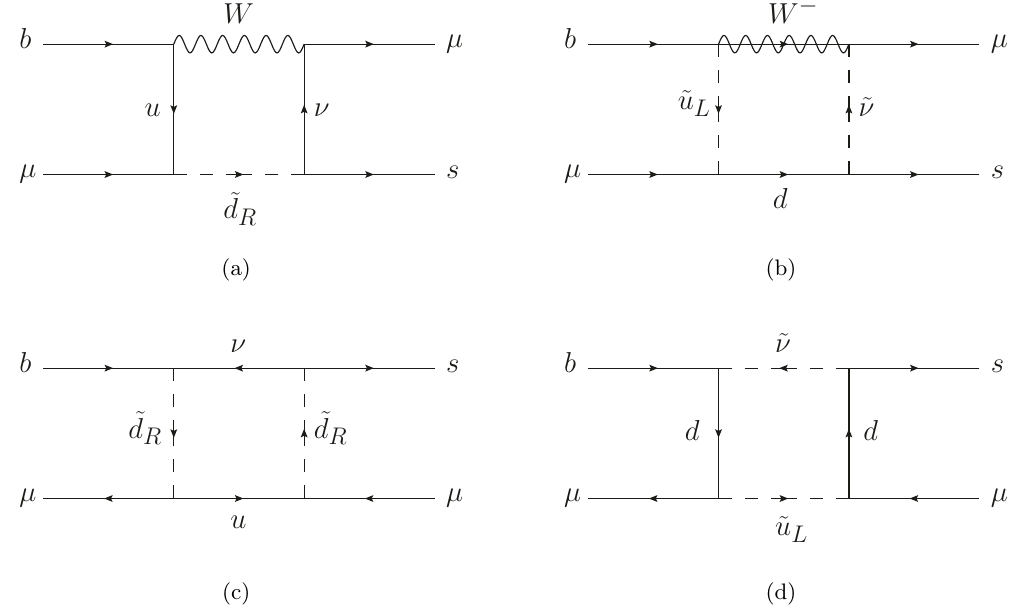
Figure 2 . Box diagrams studied in this work. Figure 2(a) shows an example W loop diagram, (cid:12)gure 2(b) shows an example wino loop diagram, and (cid:12)gures 2(c) and 2(d) show the four- (cid:21) 0 loop